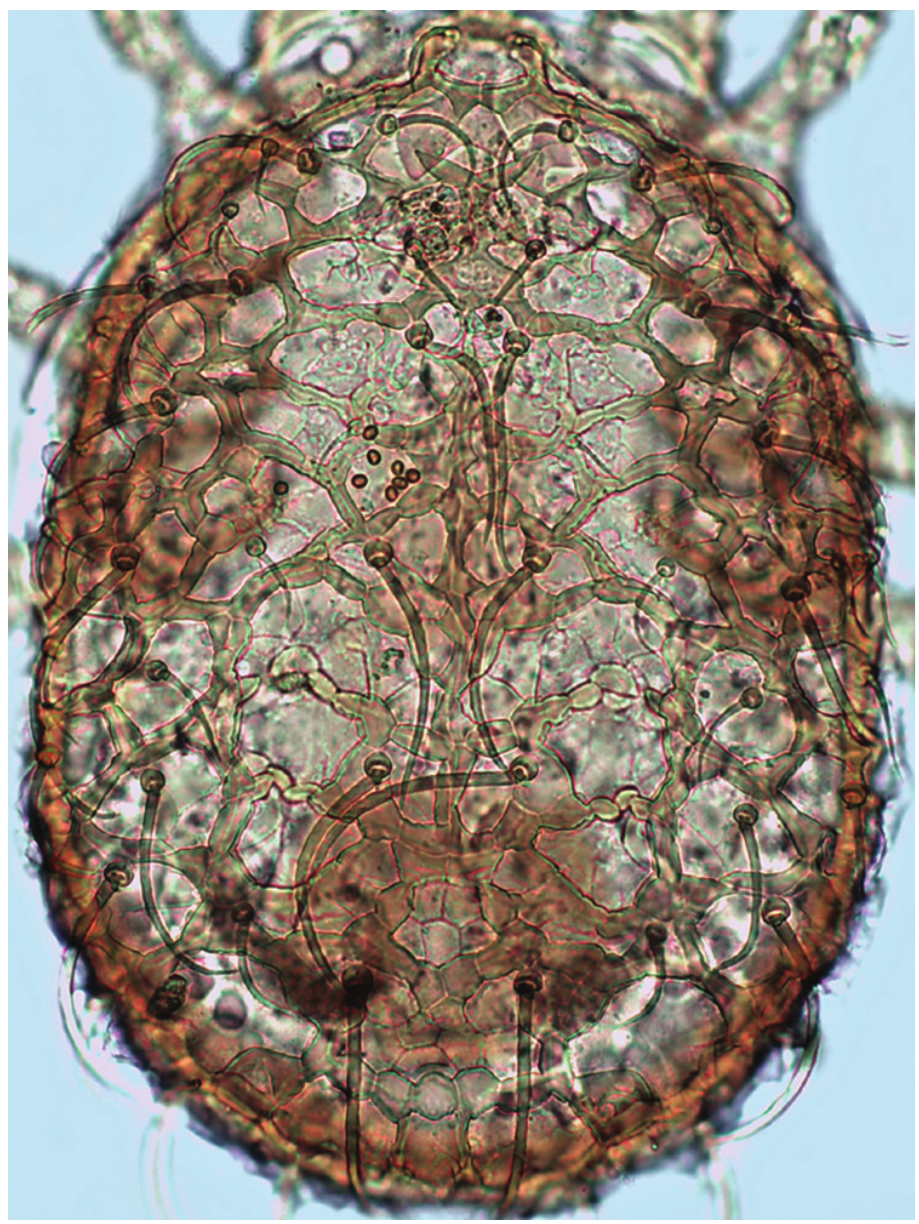
Plate 25. Ameroseius renatae , female, dorsal idiosoma (pressed